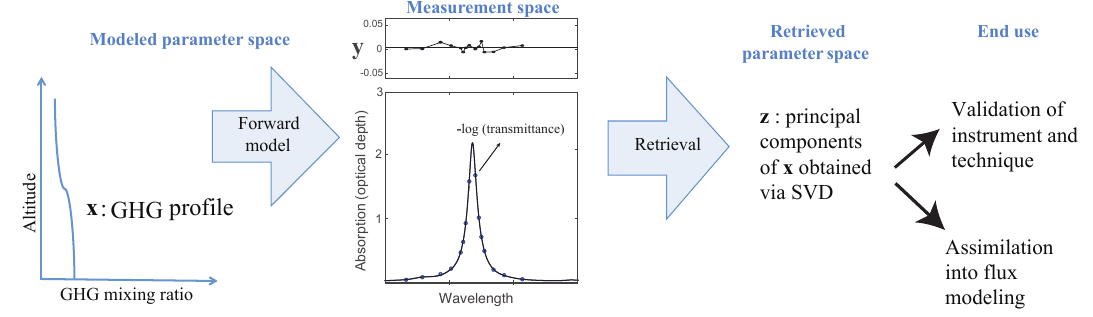
Figure 1. Schematic of the various terms involved in a greenhouse gas (GHG) measurement, retrieval and end use. The singular value decomposition (SVD) method introduces a new retrieval basis space z , which is different from the model parameter space x . In using the z basis, the SVD retrieval makes no assumptions regarding the prior GHG distribution, thus avoiding a potential source bias and making the validation and flux modeling more